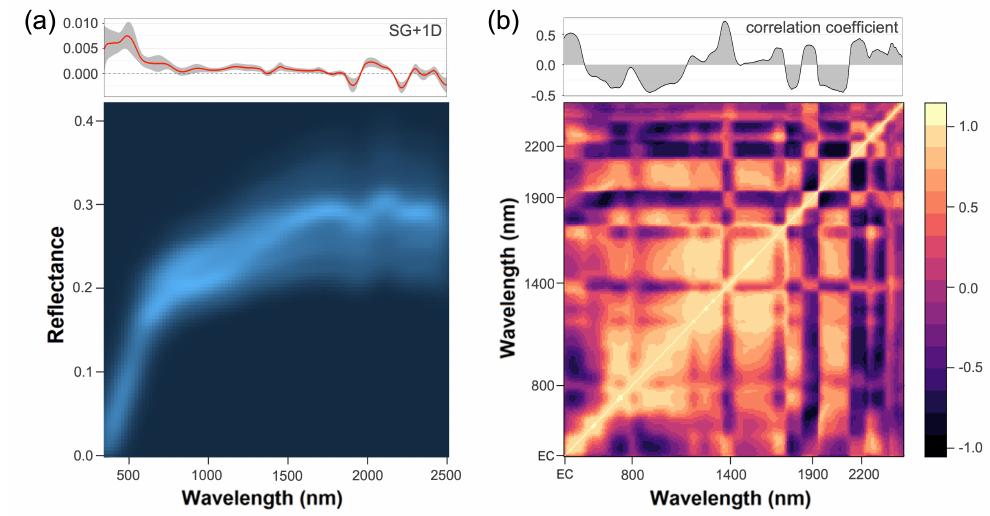
Figure 1. The reflectance spectra (by density) with preprocessed spectra ( a ), and correlation coefficient maps between measured EC and reflectance of wavelengths pairs ( b ).